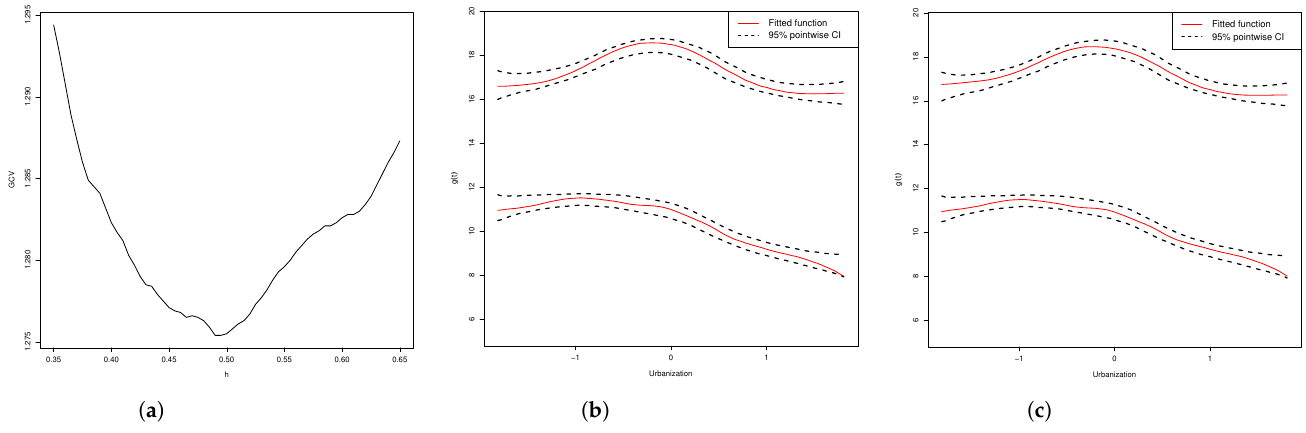
where y , x and t are CO 2 , Energyuse and Urbanisation, respectively. Figure 3a plots the GCV( h ) over a range of bandwidths, and the minimum GCV( h ) occurs at 0.4925. Figure 3b,c show the estimated non-parametric functions based on the OB-PL-EM procedure and the PL-p-EM procedure, respectively. It can be seen that there is virtually no difference between the estimated functions using the two procedures. This shows that the plug-in estimator (29) works as well as the estimator (9). Included in Figure 3b,c are plots of the 95% point-wise confidence intervals obtained via bootstrapping.